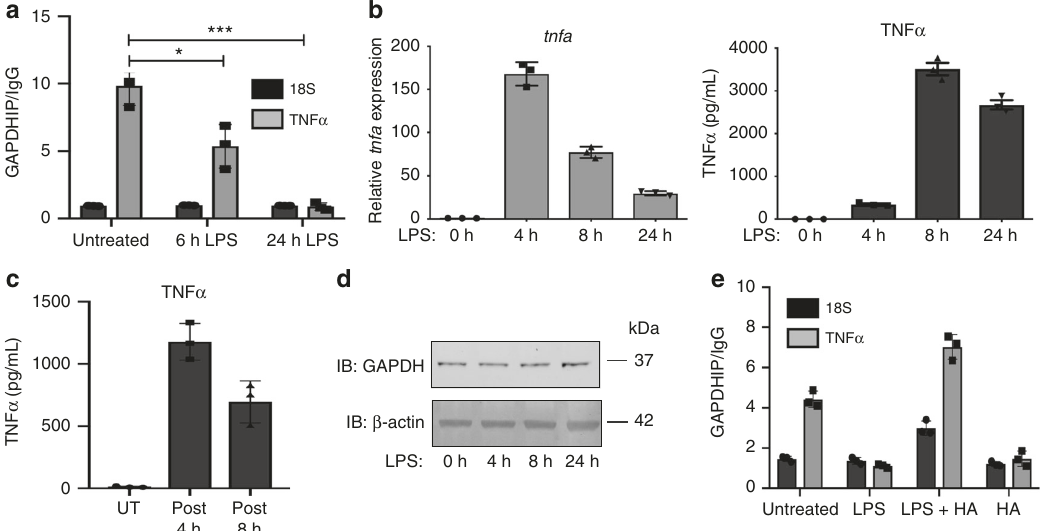
Fig. 4 GAPDH regulates TNF α post-transcriptional regulation. a GAPDH was immunoprecipitated from untreated and LPS-treated (6 and 24 h, 100 ng/mL) BMDMs, and TNF α mRNA presence in IP relative to IgG control assessed via qPCR. (mean + SEM, n = 3). b TNF α mRNA expression measured by qPCR and TNF α protein measured by ELISA in BMDMs treated with LPS (100 ng/mL) over time. c TNF α protein measured by ELISA in BMDMs treated with LPS (100 ng/mL). Cells were washed post 4 h and post 8 h LPS treatment, and supernatants replaced (without LPS) and harvested 20 and 16 h later, respectively (mean + SEM, n = 3). d GAPDH expression analysed by western blotting in LPS-treated BMDMs. e LPS-treated (100 ng/mL, 24 h) BMDMs were pre-treated with HA (10 µ M) and GAPDH immunoprecipitated. Bound TNF α mRNA was assessed by qPCR. Data shown are representative of